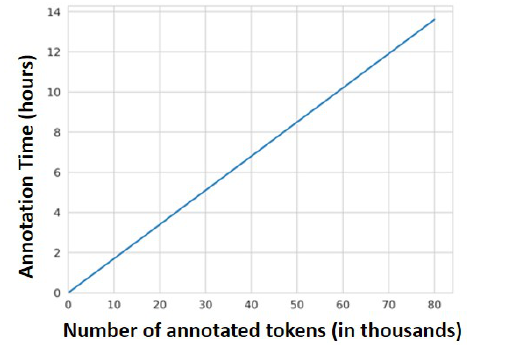
Figure 3. Estimation of the annotation time as a function of the number of tokens annotated.